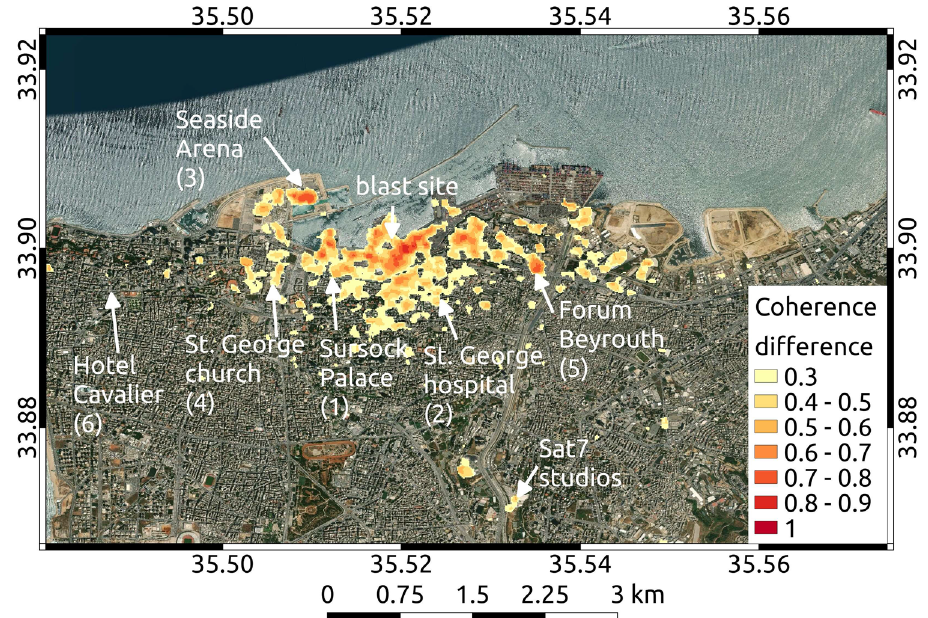
Figure 7. Low-pass filtered mean coherence loss map for illustration purposes. Shown is the coherence difference from all combined InSAR scenes. The color indicates the coherence difference, describing the coherence loss between scenes before and after the explosion. Coherence differences < 0.3 are masked. Arrows point at notable locations and sites used as ground-truth (Table 3) as reference for calibration of “Yield estimation from InSAR damage maps” section Eq. 3. Map background was created using basemap data from the Esri ArcGIS Map